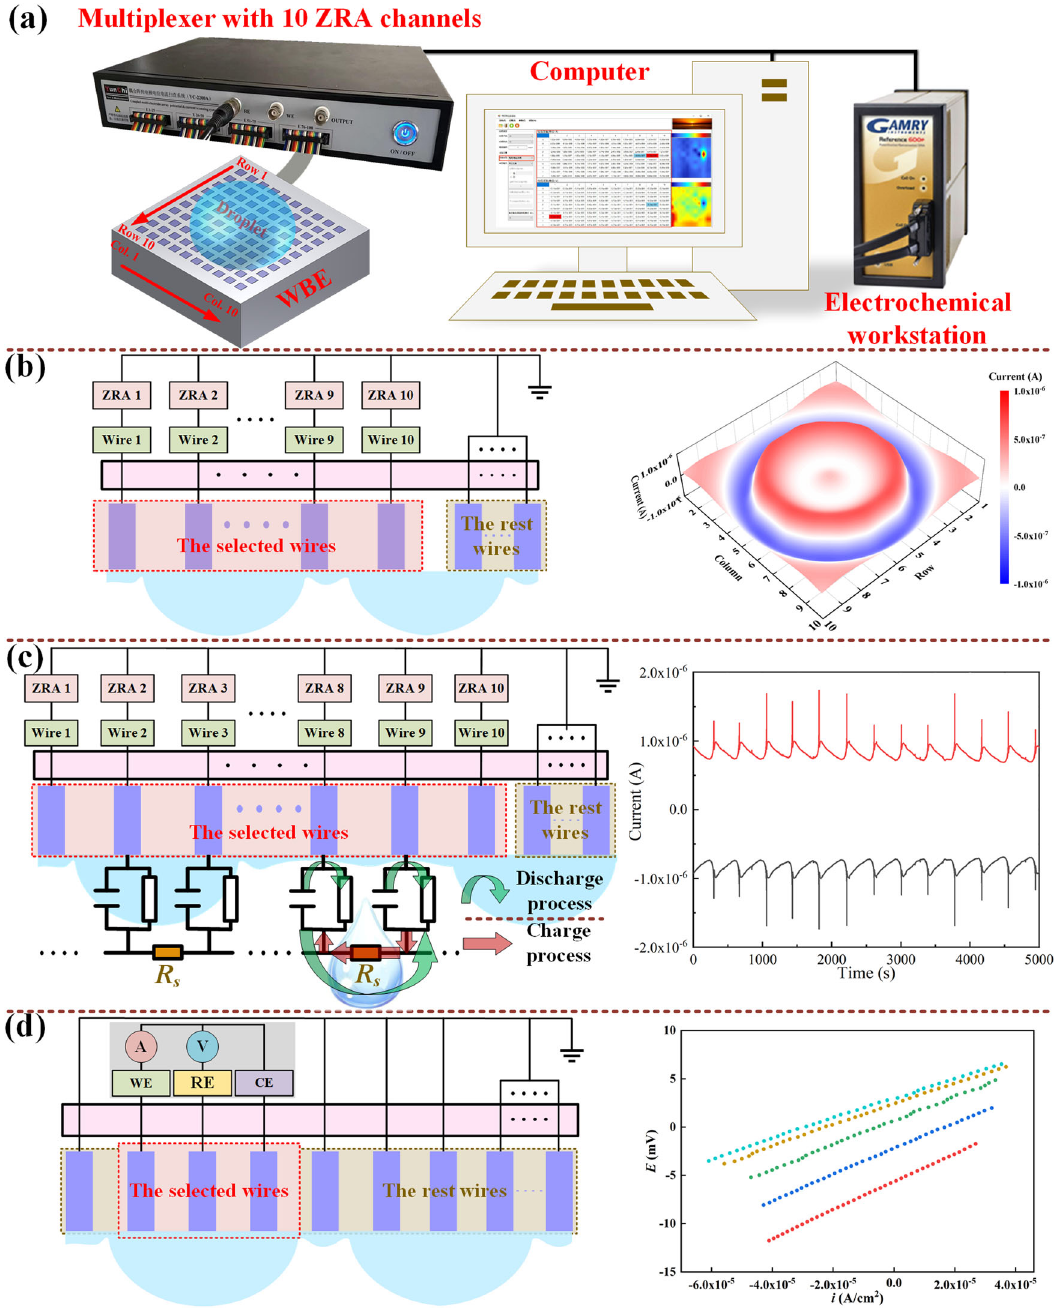
Fig. 13 The WBE sensor system used for TLC experiments. a Schematic diagram of the WBE sensor system. b The measurement circuit of the macro-cell current distribution. c The measurement circuit of DRT. d The local electrochemical measurement of the selected wire